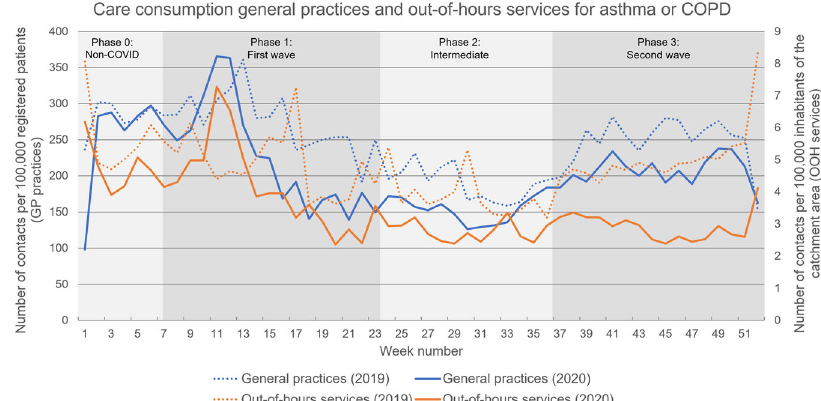
Fig. 1 The contact rates for asthma or COPD in general practices and out-of-hours services. The contact rates for asthma or COPD in general practices (blue) and out-of-hours services (orange), for 2019 (dots) and 2020